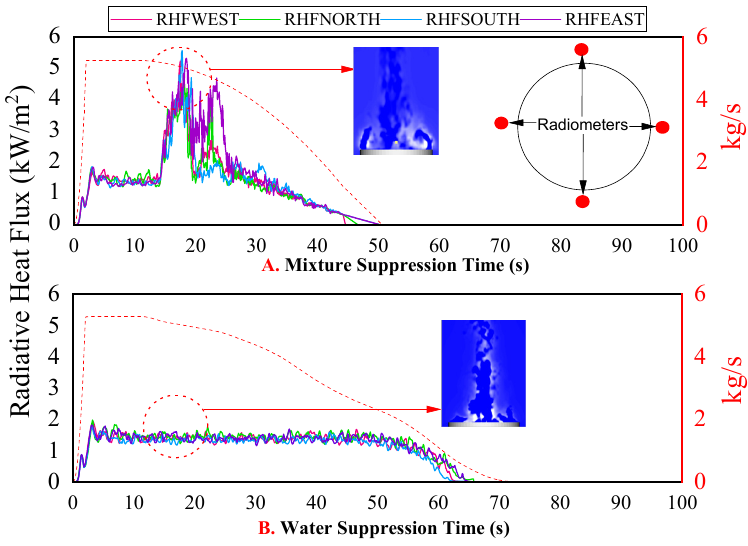
Figure 11. Comparison of radiative heat flux with a distance of 1 m each and mass loss rate before and after suppression. ( A ) Mixture suppression, ( B ) water suppression.